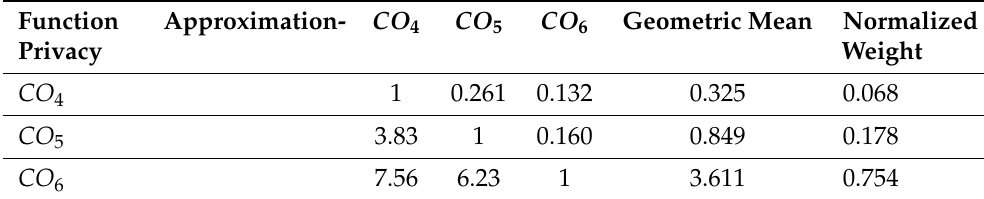
Table 14. Comparison between suitable components for function approximation with respect to privacy.